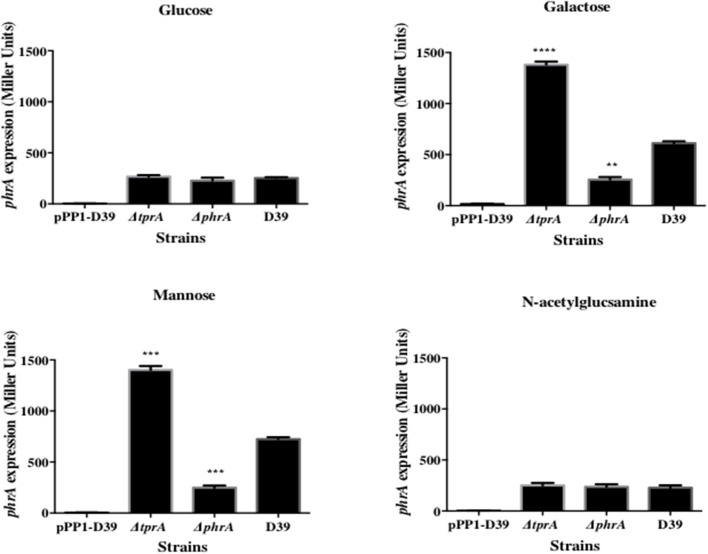
Analysis of phrA regulation in different sugars using a LacZ reporter assay. The activity of ß-glactosidase under regulation of PphrA is expressed in nmol p-nitrophenol/min/mL (Miller Units). A strain containing promoterless pPP1 plasmid (pPP1-D39) was included as a control in the assay. Values are average of three independent experiments each with three replicates. Bars indicate standard error of mean (SEM). **
p < 0.01, ***
p < 0.001, ****
p < 0.0001.